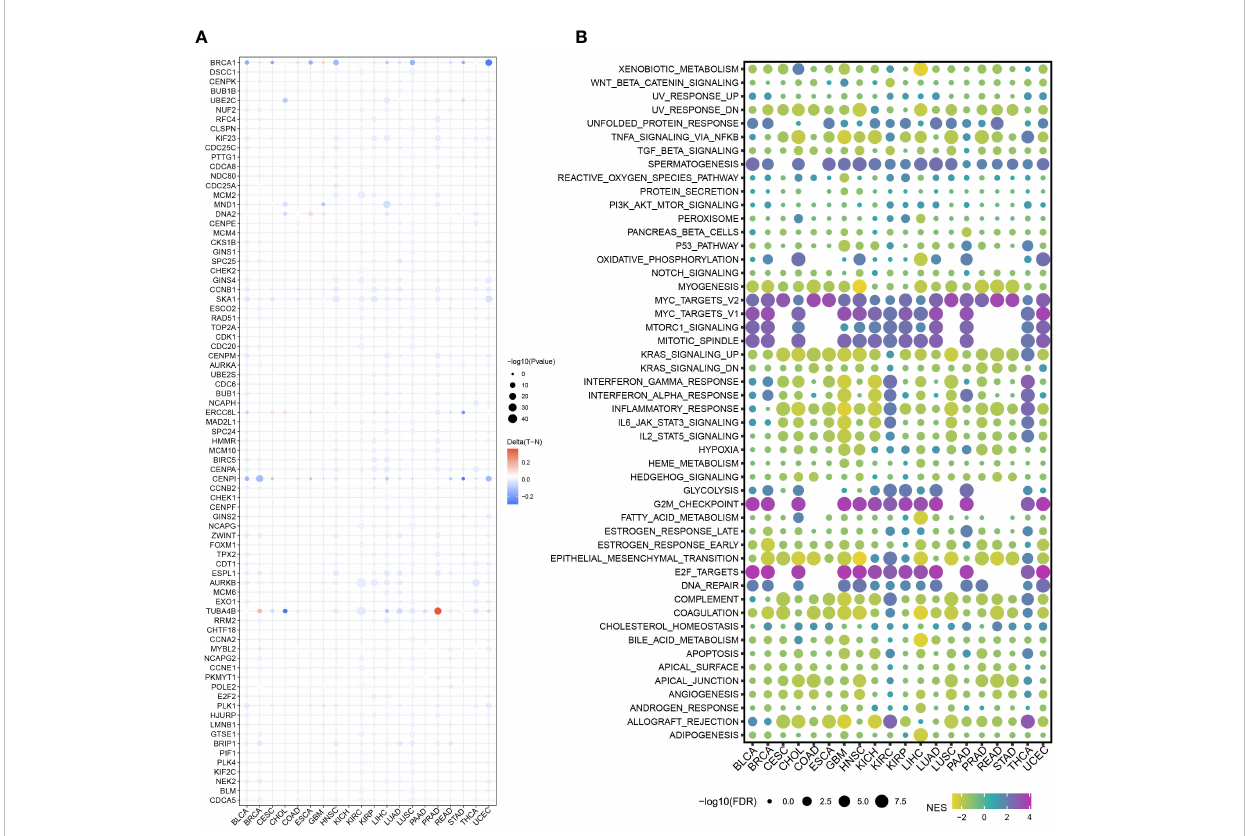
FIGURE 3 Methylation levels and pathway correlation of the cell cycle-related genes in pan cancer. (A) DNA methylation of the 93 cell cycle-related genes in different types of cancers (red to blue represents high to low). (B) 93 cell cycle-related genes were correlated with several classical tumor-related pathways (red to blue represents high to